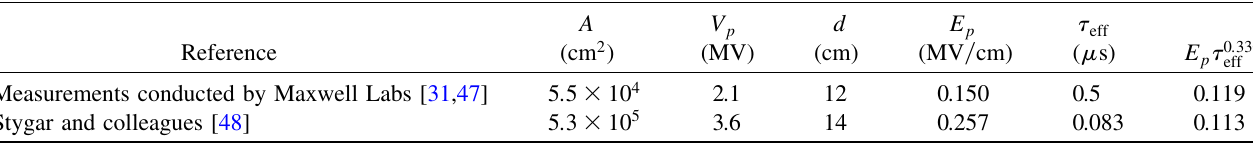
WATER-DIELECTRIC-BREAKDOWN RELATION FOR THE . . TABLE III. Conditions under which dielectric breakdown of water is observed not to occur. Each of these two observations was made on a large-area ( A * 10 4 cm 2 ) water-insulated system with a nominally uniform electric field. The quantity V voltage in time across the anode-cathode gap, d is the length of the gap, E at 63% of peak. The last column assumes E capacitor, with coaxial electrodes that have an outer radius of 60 cm and an inner radius of 48 cm [47]. The peak field E this data is that at the outer conductor, which is the anode, and has been corrected for the coaxial geometry.) The observations summarized here are consistent with the design criterion given by Eq. (11).